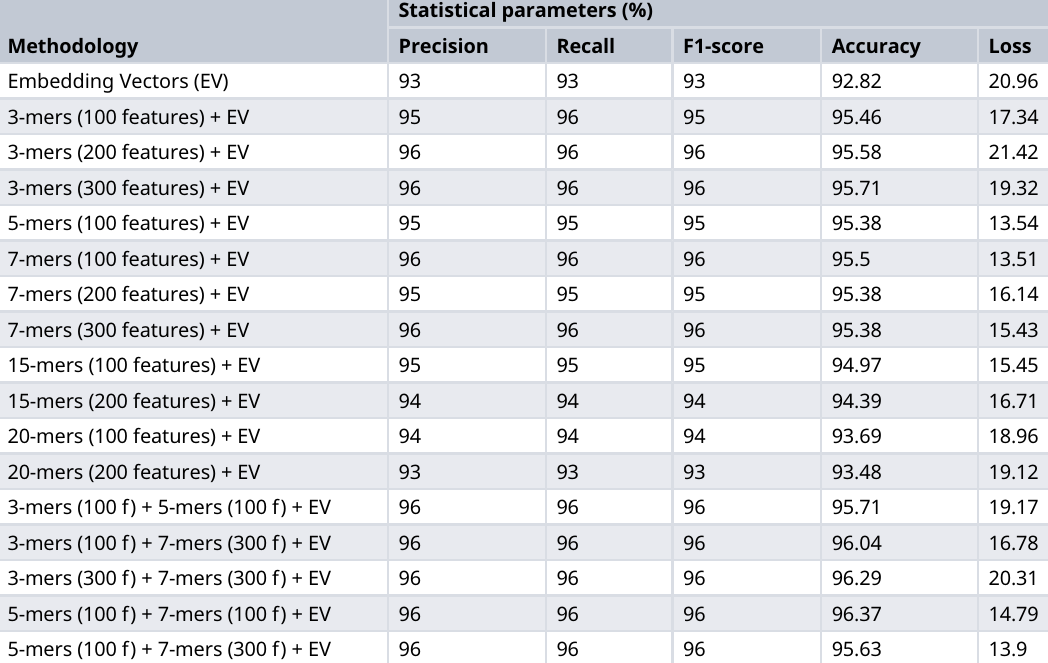
Table 2. Performance metrics (precision, recall, F1-score, accuracy, and loss) calculated for each dataset methodology.